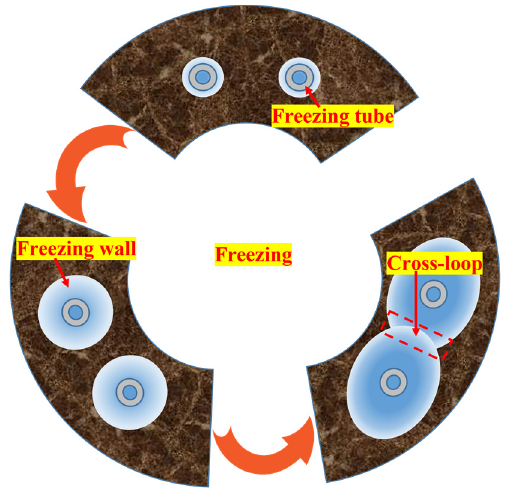
Figure 2. Schematic diagram of cross ‐ loop of frozen soil walls.